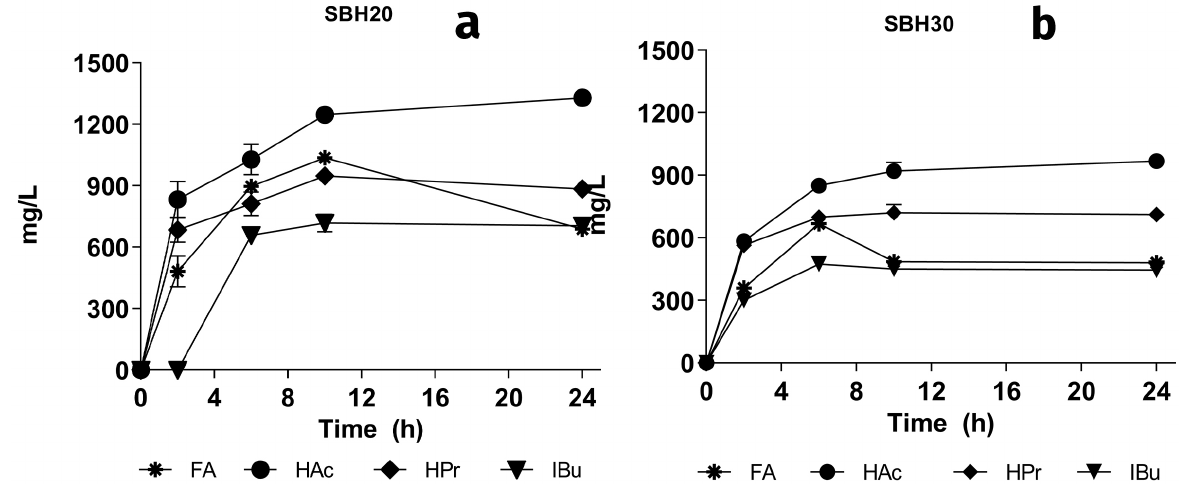
Figure 6. Concentration of volatile fatty acids (FA formic acid, HAc acetic acid, HPr propionic acid, Ibu isobutyric acid) produced by Enterobacter sp. LBTM2 along 24h fermentation of sugarcane bagasse hemicellulose hydrolysate (SBH) fermentation a) SBH20 and b)